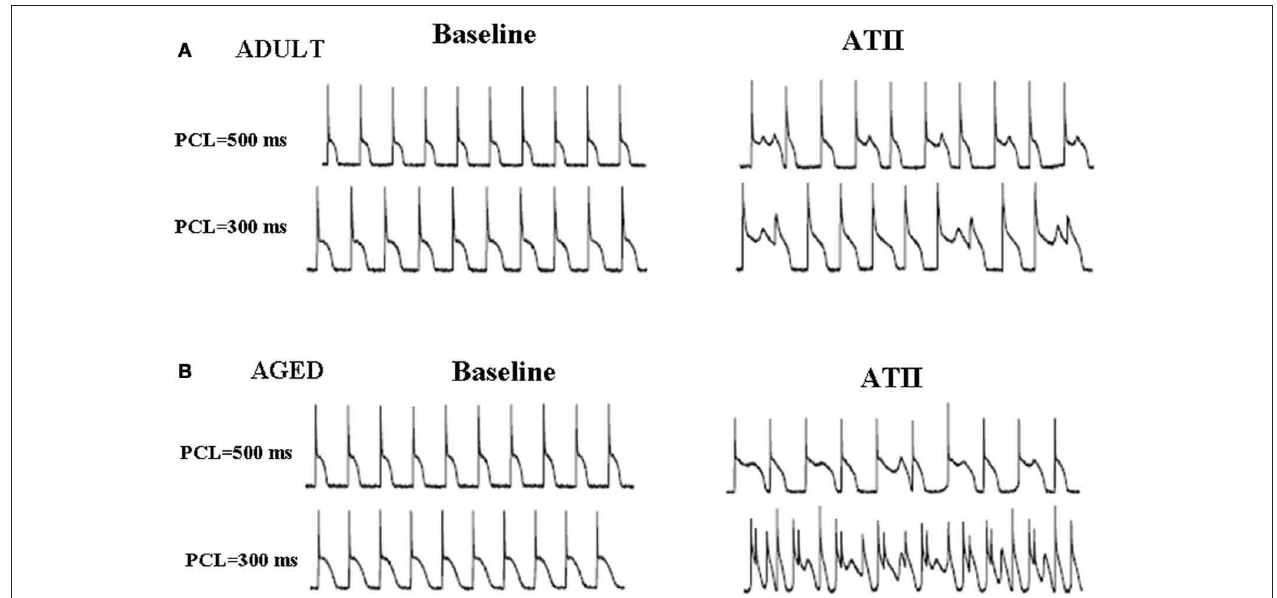
FIGURE 5 | Angiotensin II induces EADs both in young/adult (A) and aged (B) isolated LV myocytes. Effects of ATII (2 μ mol/L) in both age groups are shown at two different pacing cycle lengths (PCLs). Both